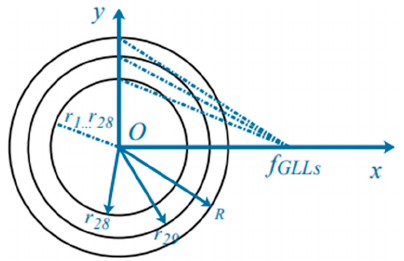
Figure 2. Internal structure diagram of GLLs. We have marked 28, 29, and 30 layers of concentric rings with different refractive indices in the figure. We use r 1 … r 28 to represent concentric rings from 1 to 28 layers, R represents the maximum radius of GLLs, and f GLLs represents the focal length of GLLs.